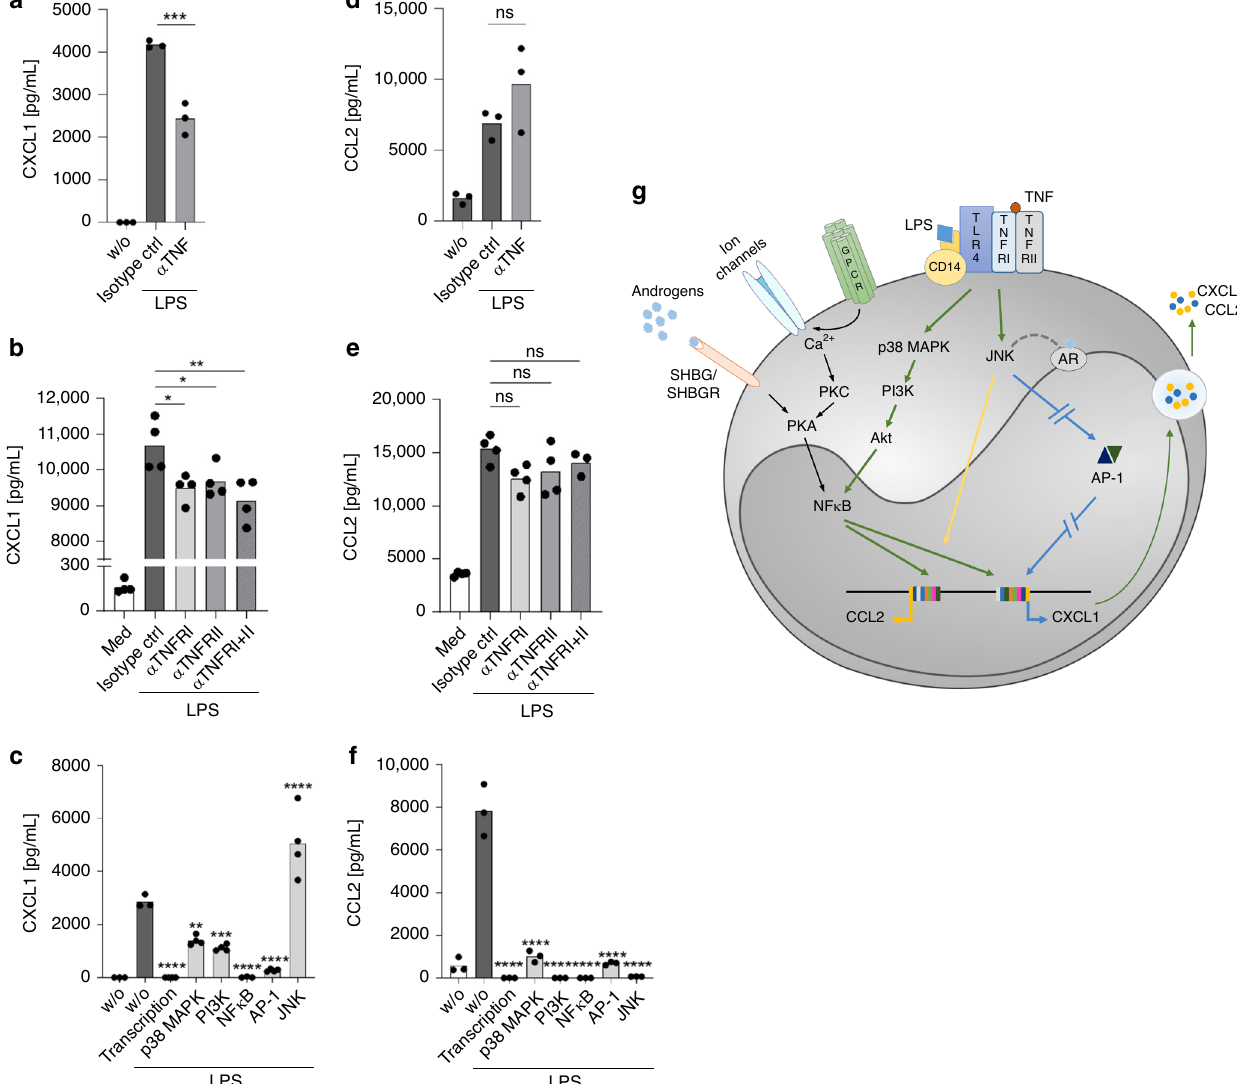
Fig. 5 Role of TNF, the MAPK pathway, and JNK in expression of CXCL1 and CCL2. MACS-puri fi ed CD14 + monocytes from men were stimulated for 24 h with LPS (0.1 µ g/mL). The concentration of a – c CXCL1 and d – f CCL2 in the supernatant was examined as follows: a , d in the presence of an α TNF mAb or an isotype IgG mAb control ( n w/o; Isotype ctrl; α TNF = 3); b , e in the presence of α TNFRI (1 µ g/mL), an α TNFRII mAb (10 µ g/mL), or an isotype control IgG mAb ( n w/o; Isotype ctrl; α TNFRI; α TNFRII; α TNFRI + II = 4); c , f in the presence of inhibitors of DNA transcription (4 µ M actinomycin D), p38 MAPK (10 µ